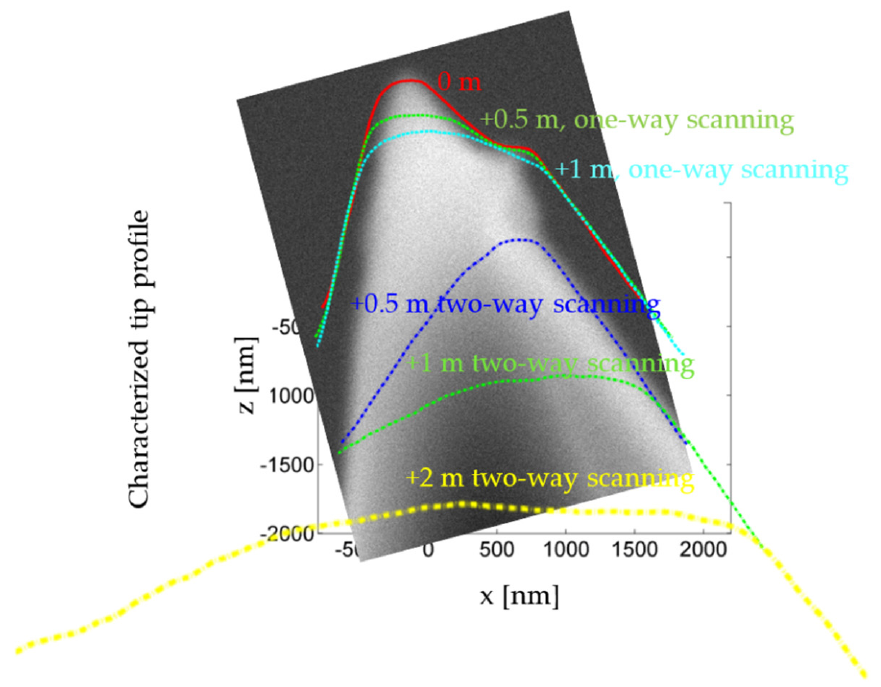
Figure 12. Change in tip profile during tip scanning.